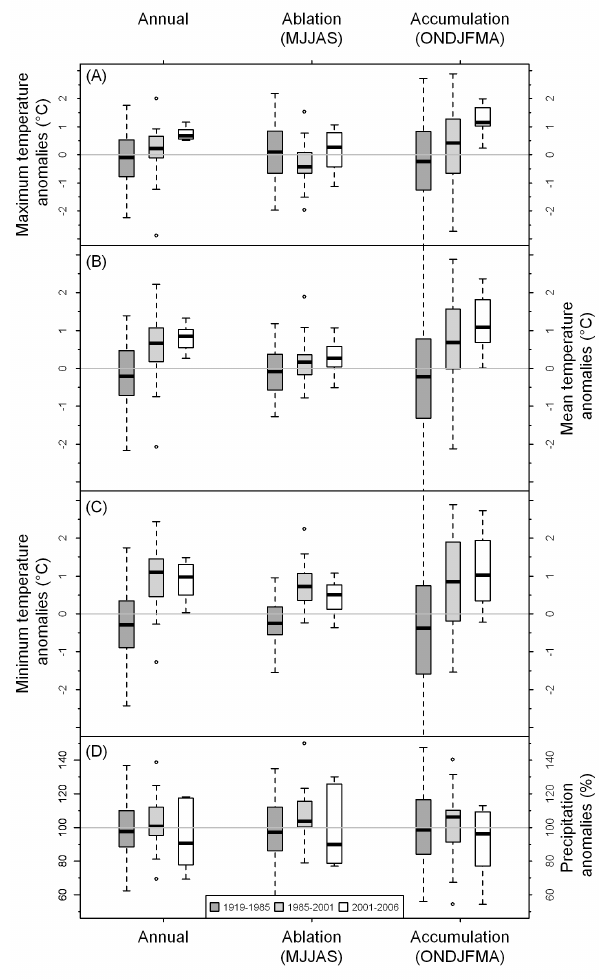
Fig. 9. (A) Maximum, (B) mean, and (C) minimum temperature anomalies calculated for the average annual, ablation, and accumu- lation seasons for the periods 1919–1985, 1985–2001, and 2001– 2006. (D) Precipitation anomalies calculated from precipitation dur- ing the hydrologic year (annual), and precipitation during the abla- tion and accumulation seasons for the same periods. The climatic mean is based on the period